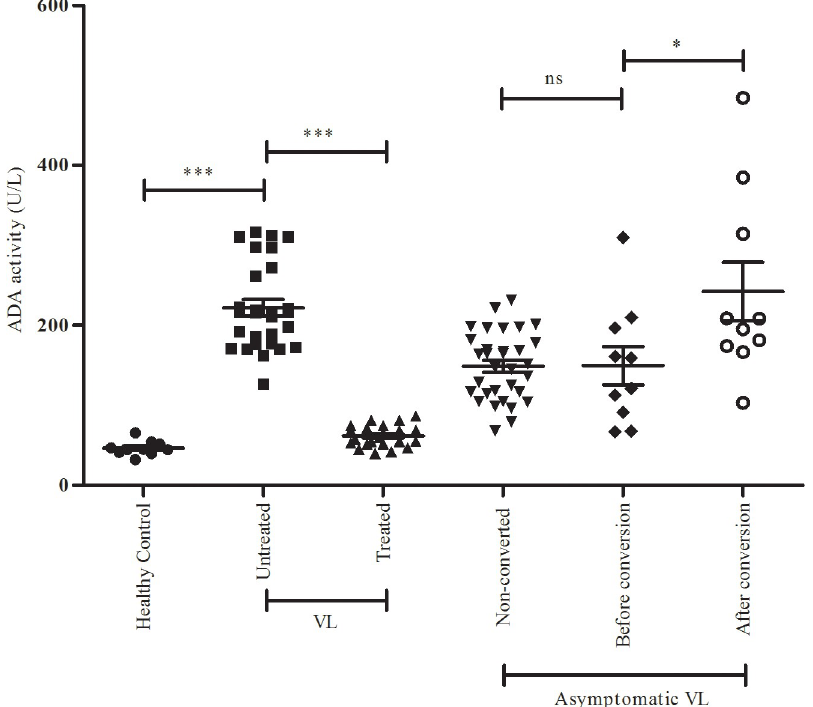
Fig 2. Serum ADA activity of healthy subject (n = 10), VL untreated (n = 28), VL treated (n = 23), Non-converted (n = 32) asymptomatic VL and after conversion into VL (n = 10) (Before conversion and after conversion (6 month)). Non-significant (ns), ��� P < 0.0001, � P < 0.05.